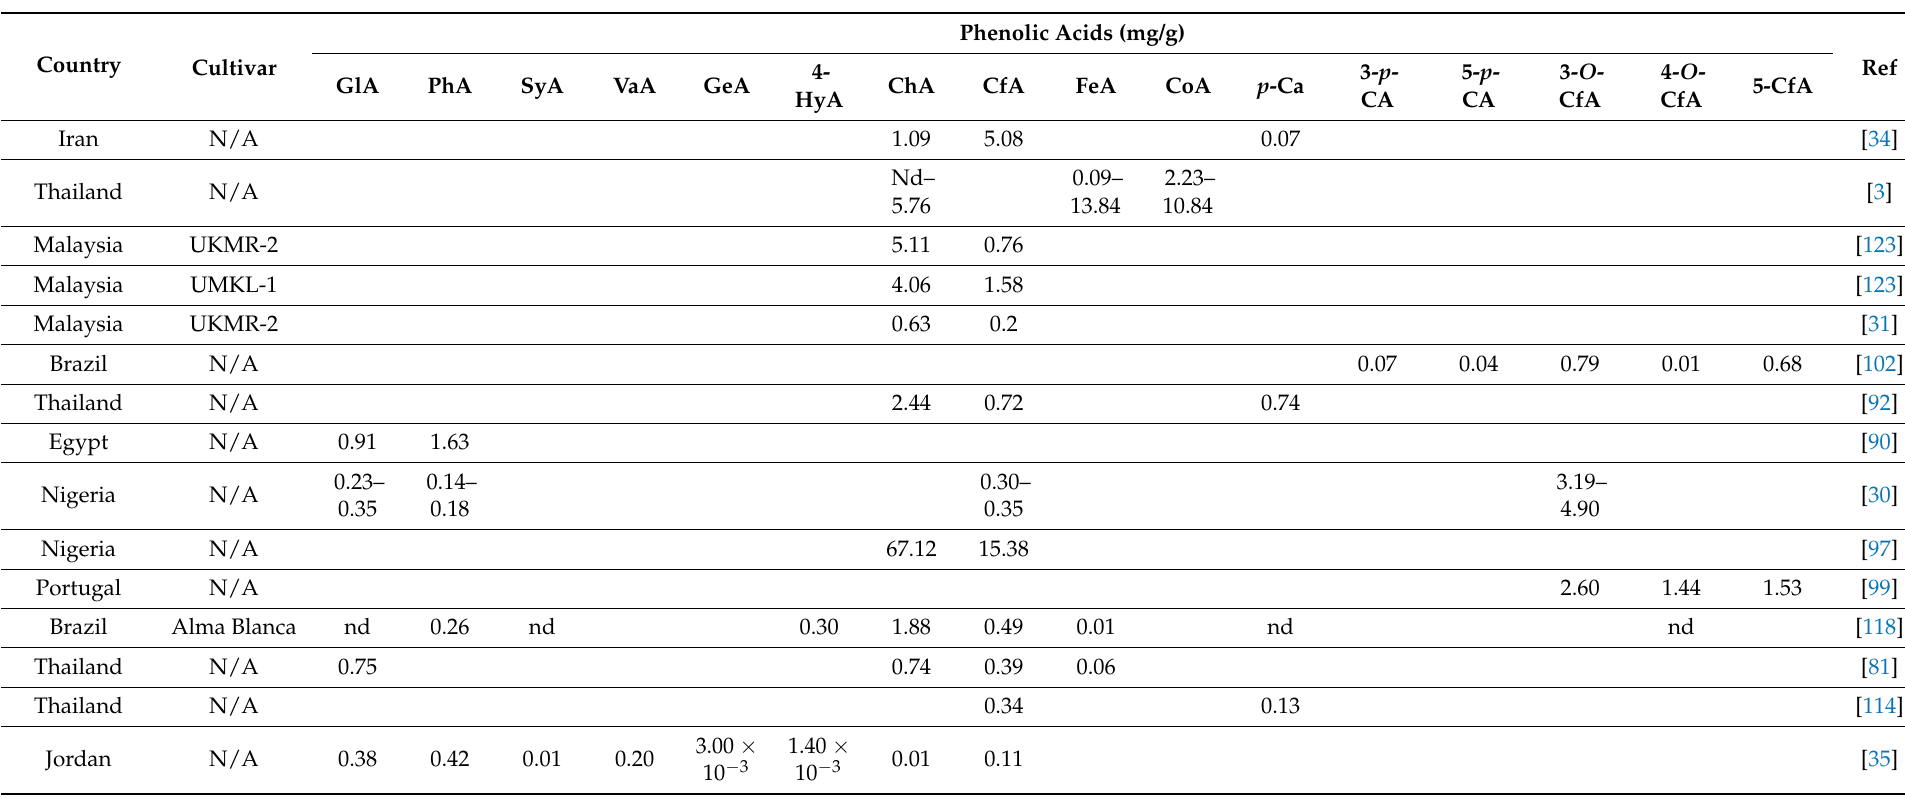
Table 4. Phenolic acids from roselle calyx. Abbreviations: N/A: not available, nd: not detected, GlA: gallic acid, PhA: protocatechuic acid, SyA: syringic acid, VaA: vanillic acid, GeA: genistic acid, 4-HyA: 4-hydroxybenzoic acid, ChA: chlorogenic acid, CfA: caffeic acid, FeA: ferulic acid, p -Ca: p -coumaric acid, 3- p -CA: 3- p -coumaroylquinic acid, 5- p